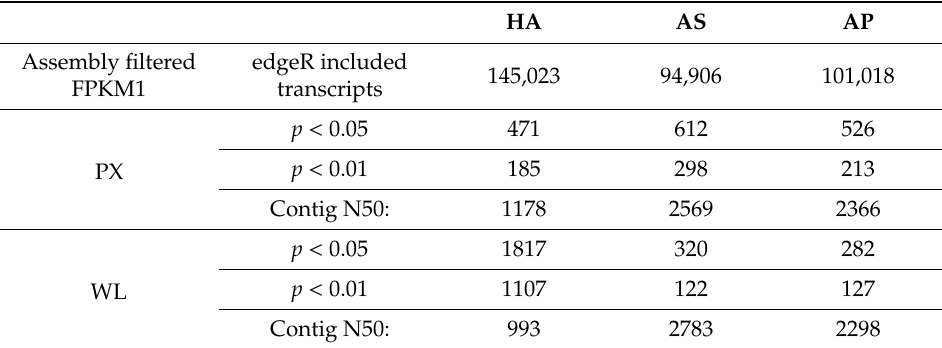
Table 2. Results from the di ff erential expression